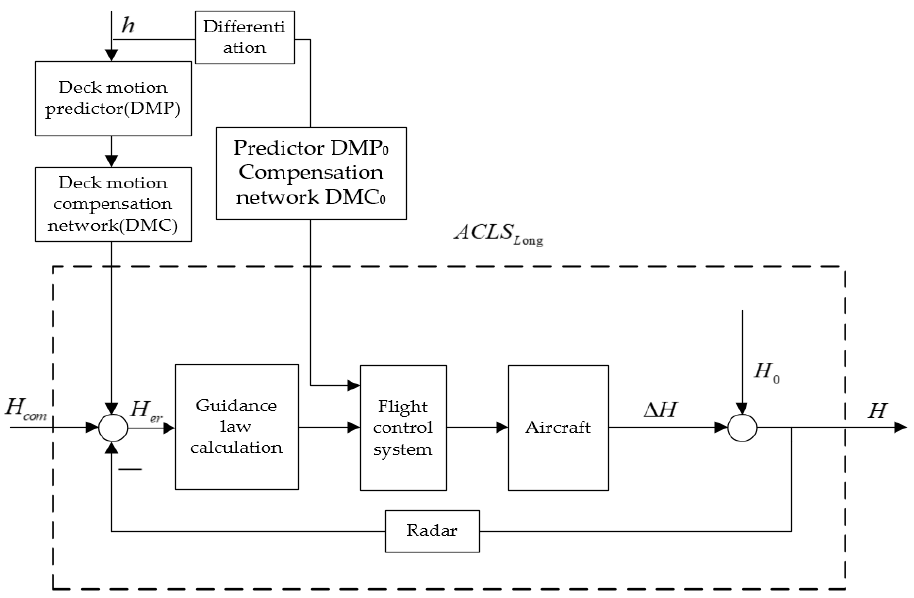
Figure 2. The structure of the longitudinal automatic landing guidance system with the velocity signal of deck motion.